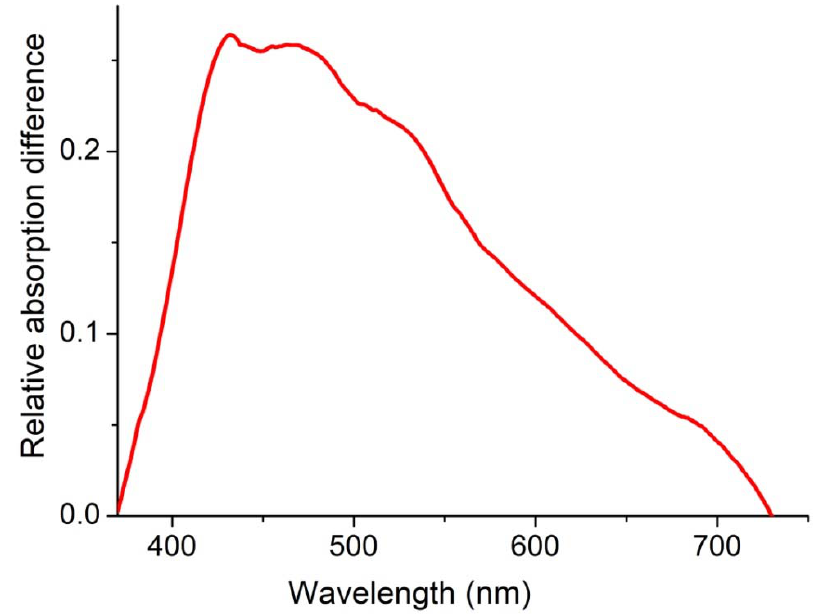
Figure 3. Relative excess absorption of TiO 2 -S-Arg samples compared to TiO 2 -S-Air samples.